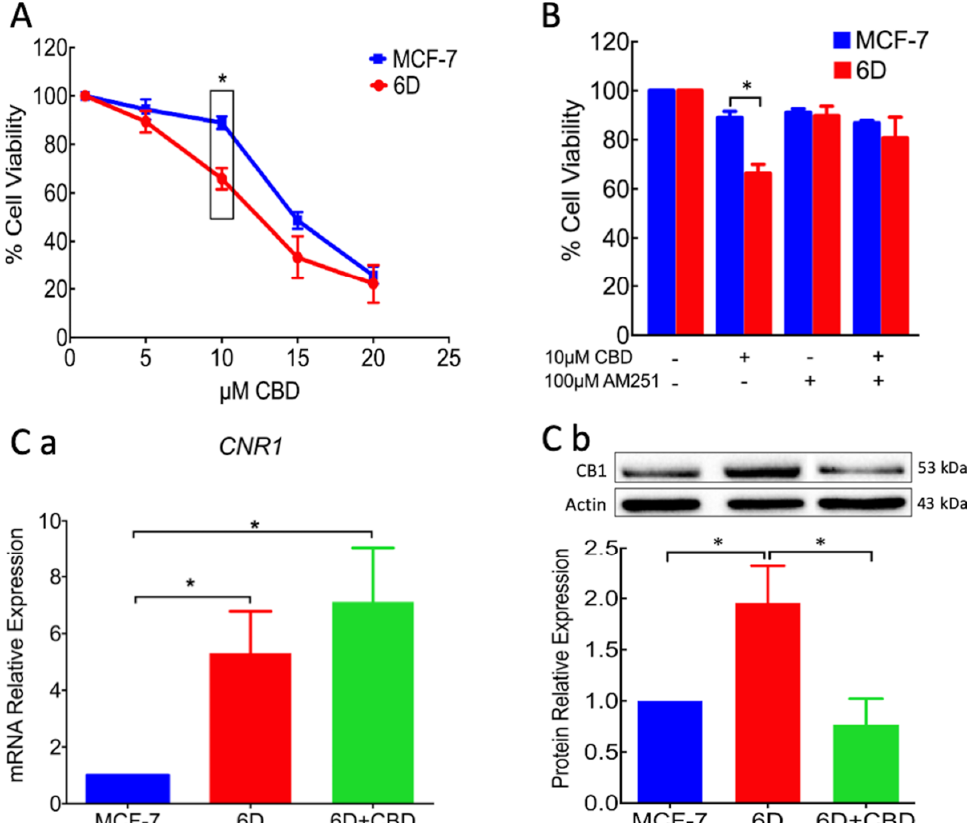
Figure 1. Cell viability and CB1 receptor expression in MCF-7 and 6D cells treated with CBD. ( A ) Cannabidiol concentration–response curve by cells after 48 h treatment. At 10 µM CBD, the viability difference between the two cell types was statistically significant (Box). ( B ) Cell viability of MCF-7 and 6D cells treated in three different experimental conditions: (1) cells without any treatment, (2) cells treated with 10 µM CBD, (3) cells treated with 100 nM AM251 and (4) cells treated with AM251 and then with CBD. The MCF7 and 6D cells without any treatment were given 100% viability values in these experiments, data represent three independent batches of cells (biological replicates) were each examined in triplicate (assay replication, n = 9). ( Ca ) CNR1 gene expression determined by qRT-PCR in MCF-7 and 6D cells treated or not treated with CBD. ( Cb ) A representative Western blot of CB1 protein in the three types of cells and the densitometric analysis of CB1 levels. The values were normalized to actin as the protein load control and expressed relative to those in MCF-7 cells. The mRNA expression and Western blot results represent the average of three independent experiments ± SD ( n = 3). Asterisks indicate significance at p < 0.05.